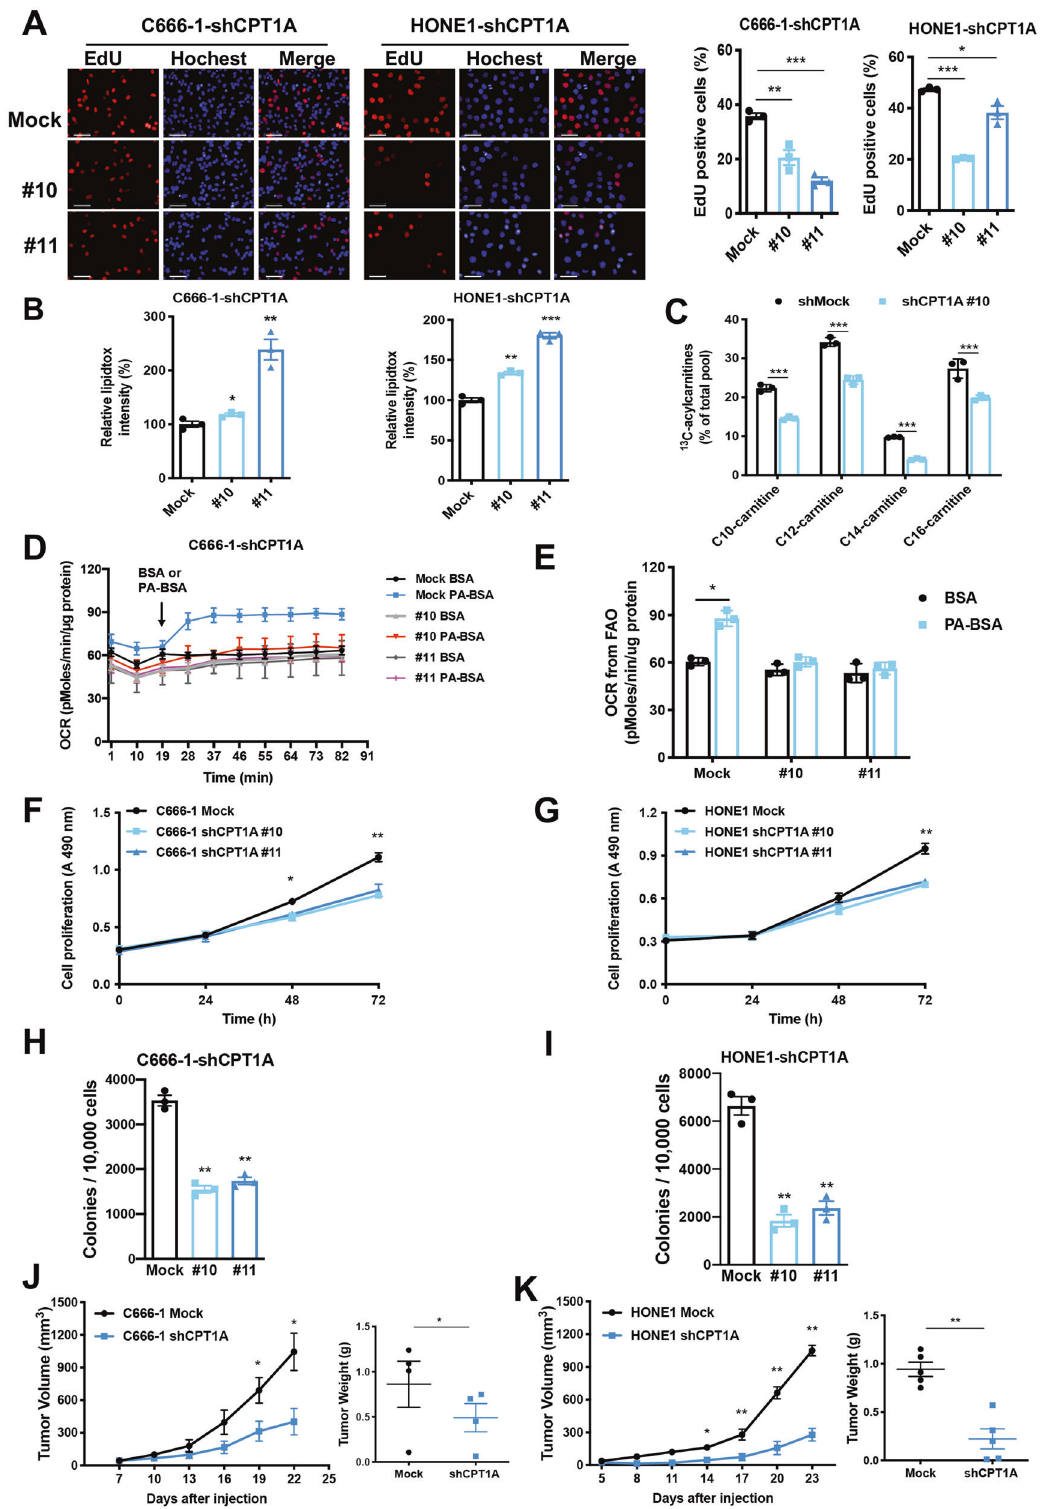
FAO (Supplementary Fig. S2C). Knockdown of CPT1A reduced ATP content in C666-1 cells (Supplementary Fig. S2D) and over- expression of CPT1A increased the ATP content of cells (Supplementary Fig. S2E). These results suggest that CPT1A, a key FAO enzyme, can promote energy metabolism in NPC